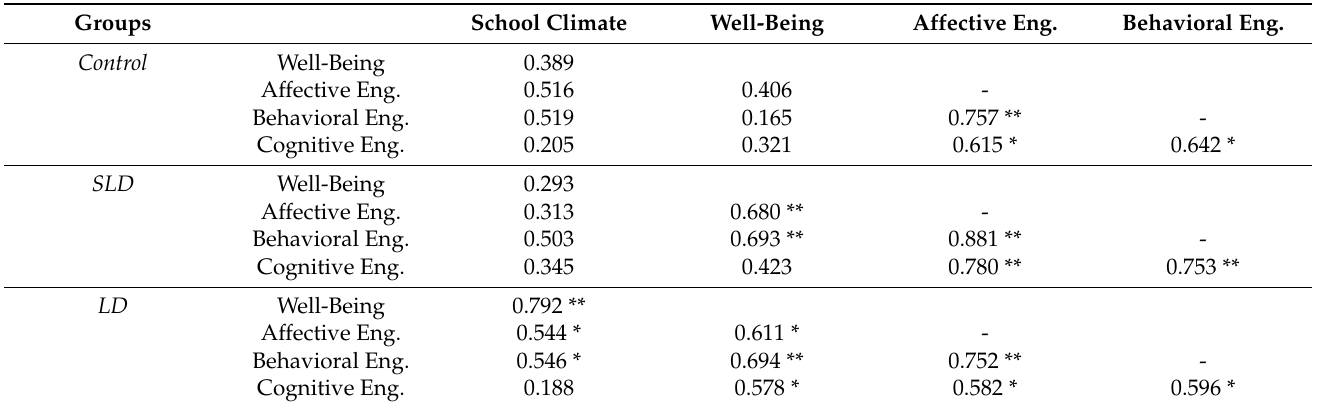
Table 2. Correlations between school climate, well-being and student engagement. Groups School Climate Well-Being Affective Eng. Behavioral Eng. Control